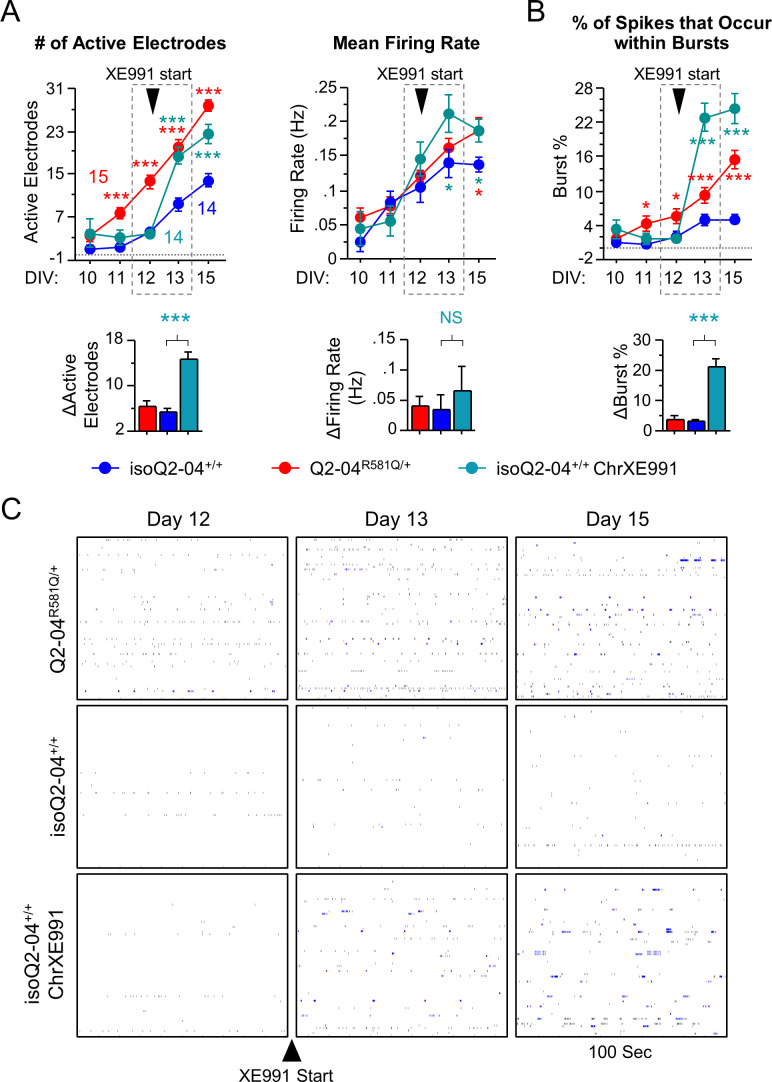
Early effects of chronic XE991 treatment on control neurons.(A) Early MEA recordings from days 10 to 15 in culture. Q2-04R581Q/+ neurons exhibit a greater number of electrodes that became active (≥1 spike/min) earlier on in differentiation compared to isoQ2-04+/+, indicating more neurons could fire spontaneously earlier (Also see Figure 2—figure supplement 1A). Within 24 hr of XE991 treatment, isoQ2-04+/+ neurons (isoQ2-04+/+ ChrXE991) exhibited a threefold increase in the number of active electrodes relative to untreated isoQ2-04+/+ neurons (ΔActive Electrodes, t test: p<0.0001). Although there was a significant genotype group difference in the mean firing rate (repeated measures ANOVA for genotype group: F(2,160) = 3.73, p=0.0327), there was no differences between the groups on individual days 10–12 (Fisher’s PLSD posthoc test). Also, the mean firing rate increased, from day 12 to day 13, equally between the groups (ΔFiring Rate, t test: p=0.7136). (B) The percentage of spikes that occur in bursts (burst %) was higher in Q2-04R581Q/+ neurons compared to isoQ2-04+/+ beginning on day 11. After application of XE991, isoQ2-04+/+ neurons exhibited a sevenfold increase in burst % relative to untreated isoQ2-04+/+ neurons (ΔBurst %, t test: p<0.0001). Red * indicate significant difference between Q2-04R581Q/+ and untreated isoQ2-04+/+ neurons and teal * indicate significant difference between chronically XE991-treated isoQ2-04+/+ and untreated isoQ2-04+/+ neurons at each time point. (C) Representative spike raster plots from 100 s of a single MEA well of Q2-04R581Q/+, isoQ2-04+/+ and isoQ2-04+/+chronic XE991 neurons before (Day 12) and after (Day 13–15) XE991 treatment. Each row represents the signal detected by a single electrode; black ticks indicate single spikes and blue ticks spikes that occur within bursts. Values displayed are mean ± SEM.Figure 6—figure supplement 2—source data 1.Quantification of DIV 10–13 MEA data parameters for Figure 6—figure supplement 2.